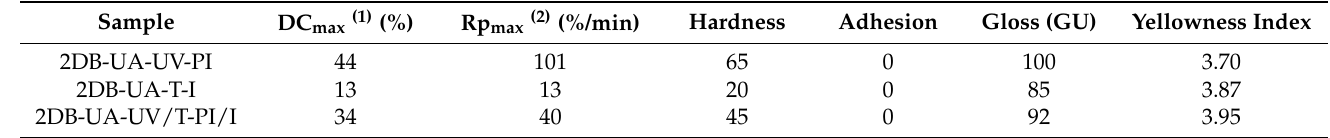
Table 4. The basic properties of the cured coatings based on 2DB-UA resin with respect to the curing method.